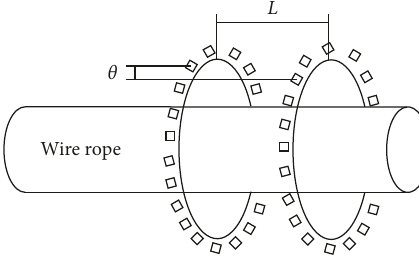
Figure 2: Double detection board schematic.